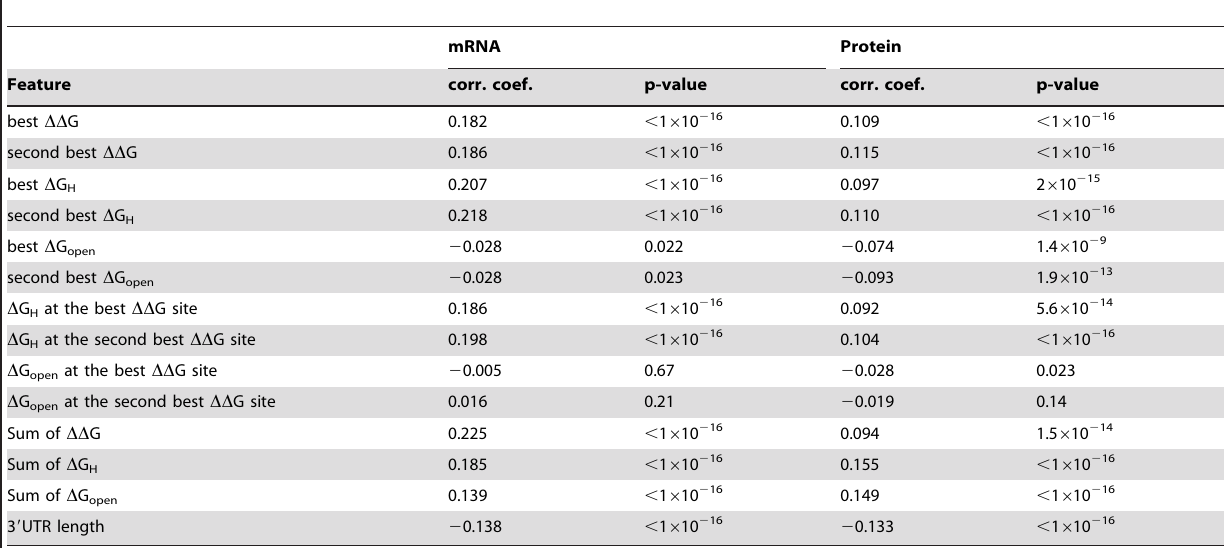
Table 1. Correlation between energy features, as well as 3 9 UTR length, and observed level of down-regulation.